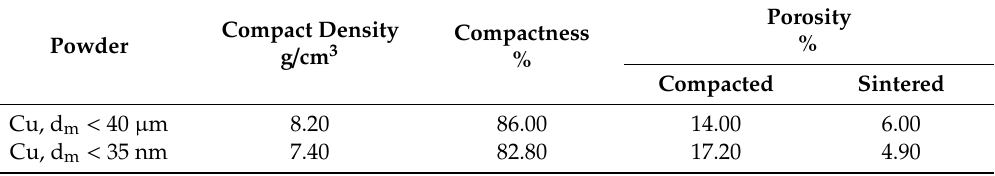
Table 1. Technological points of reference for copper powders.